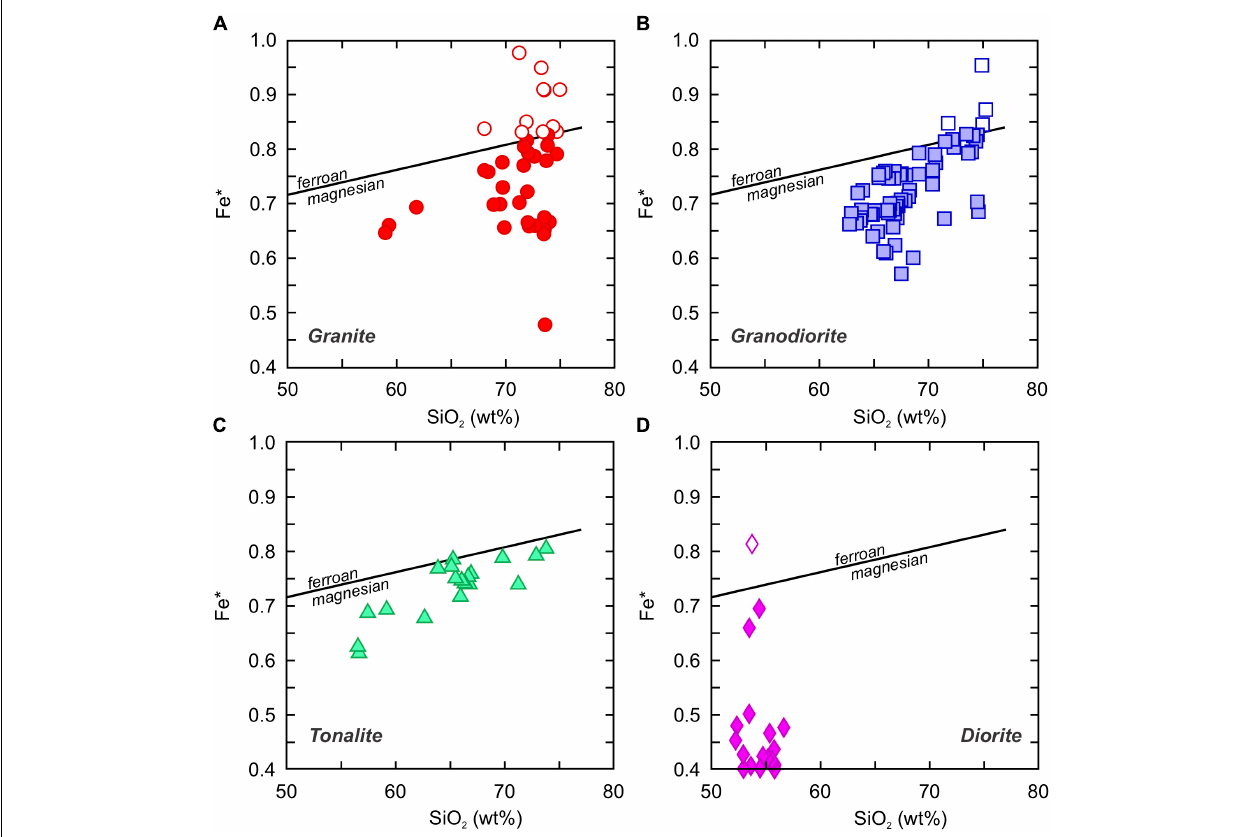
FIGURE 2 | Division of the Cretaceous (A) granites, (B) granodiorites, (C) tonalites, and (D) diorites from Kyushu into ferroan and magnesian compositions using the Fe* [FeOt/(FeOt + MgO)] vs. SiO 2 (wt%) discrimination of Frost et al.